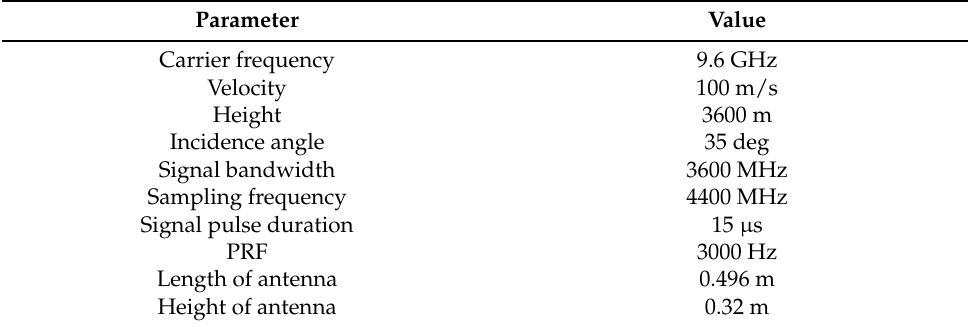
Table 2. Parameters in Point Target Simulations.